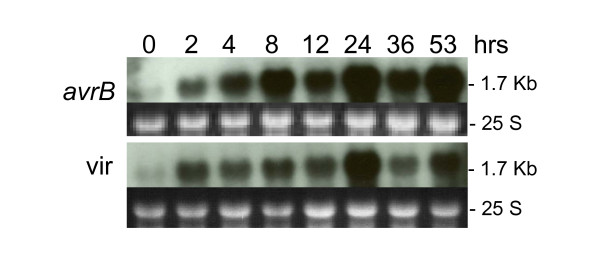
Isoflavone synthase (IFS) RNA (1.7 kb) profile. Measurements made at 8 intervals through a 53 hr period in response to infection by Pseudomonas syringae pv glycinea with avrB (avrB) or without (vir) (First and second panels respectively). Dark background sub-panels are the 25 S ribosomal RNAs from corresponding ethidium bromide-stained gels prior to membrane transfer and shown to compare sample loading. The Gm-c1059-264 soybean cDNA clone was used as probe.